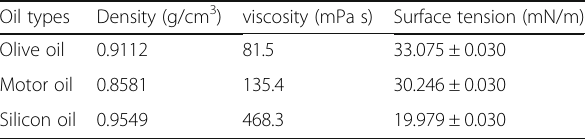
Additional file 1: Figure S1. SEM pictures (lower magnification) of the porous electrospun PVDF fibers. Figure S2 The diameter of fiber. Figure S3 and S4 SEM pictures (lower magnification) of the rough and grooved electrospun PVDF fibers. (DOCX 2656 kb)